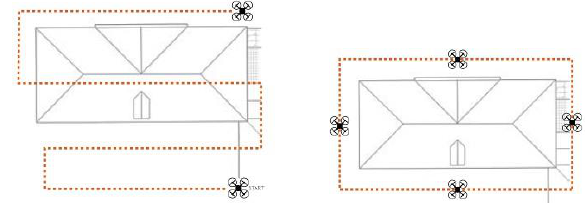
Figure 4. Scheme of the UAV acquisition (nadir stripes left, oblique acquisition route right) of Palazzo Sarmatoris.